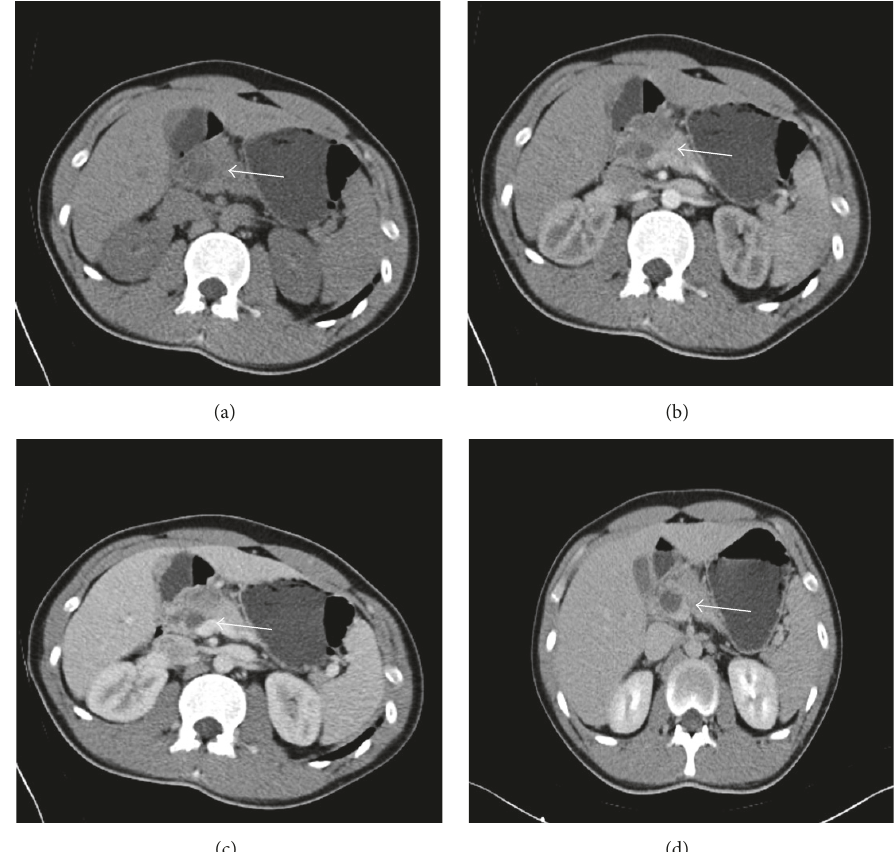
Figure 2: The CT scan revealed that the enlargement of the head of pancreas had an irregular density and unclear boundary. Moreover, inhomogeneous enhancement and progressive enhancement appeared after using iodinated contrast material. (a) CT scan, (b) arterial phase, (c) portal phase, and (d) delayed phase